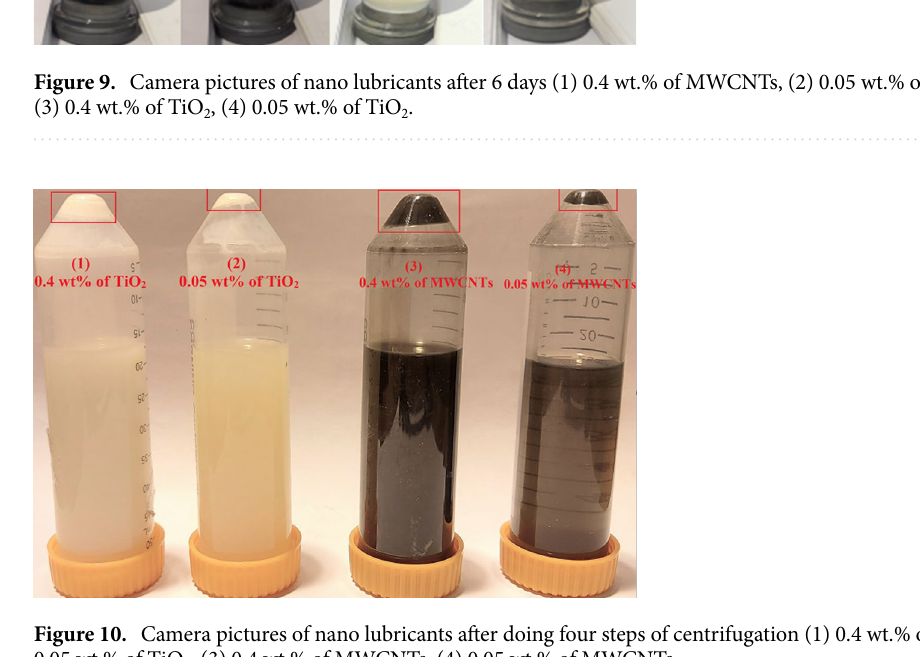
Figure 10. Camera pictures of nano lubricants after doing four steps of centrifugation (1) 0.4 wt.% of TiO 2 , (2) 0.05 wt.% of